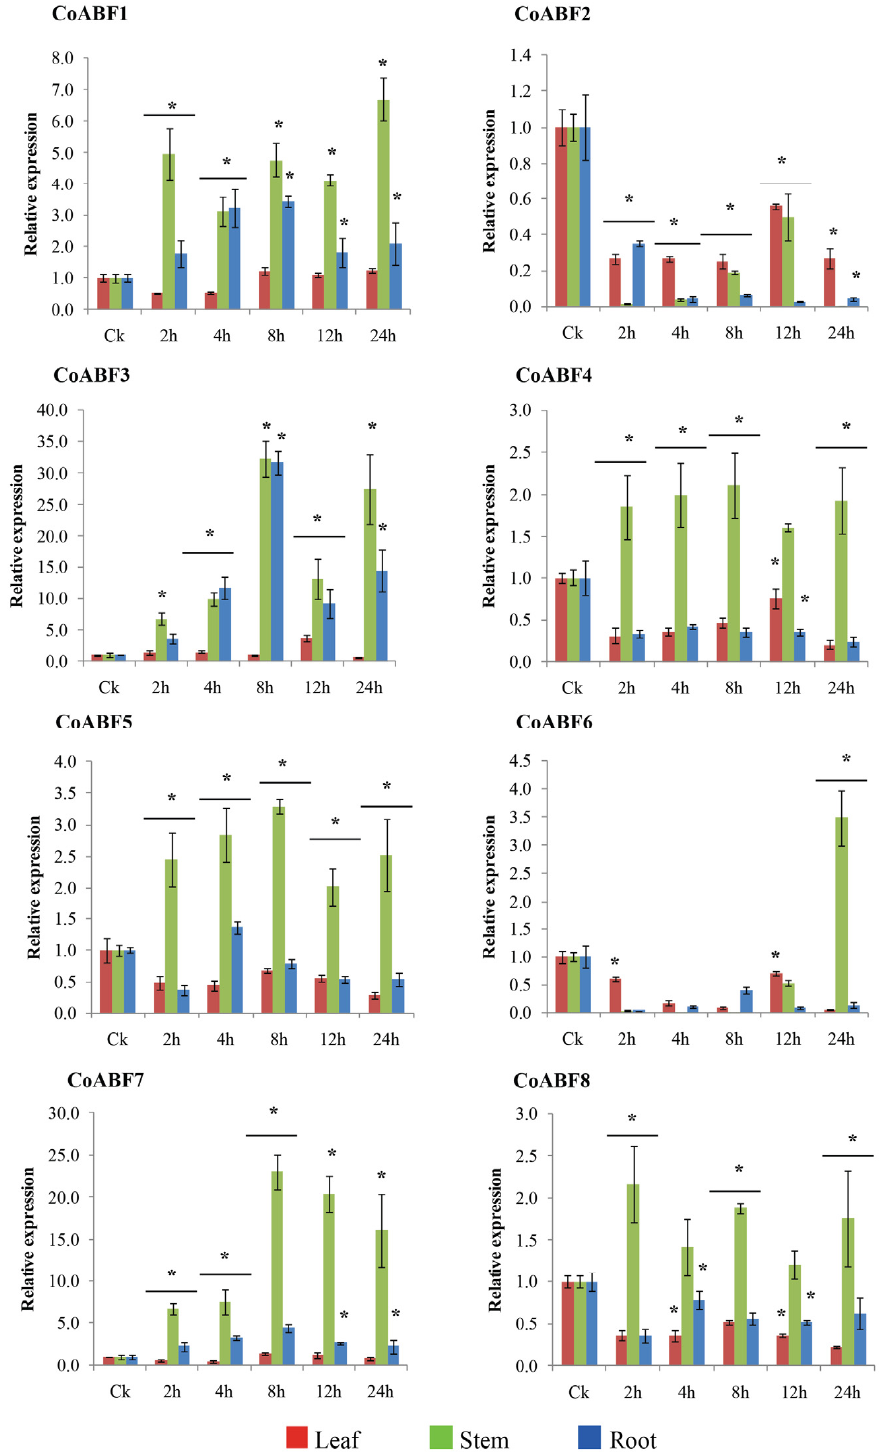
Figure 5. Relative expression of eight CoABF genes in jute tissues (leaf, stem, and root) measured under exogenous ABA (100 µmol/L). Data represent the means of three independent replicates ± standard deviation (SD). Asterisks denote statistically significant differences (* p ≤ 0.05) compared to the control (CK).